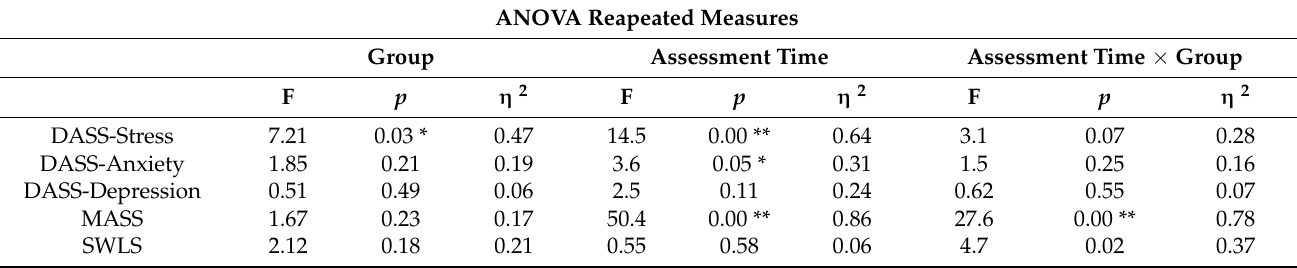
Table 4. Results of the ANOVA of all